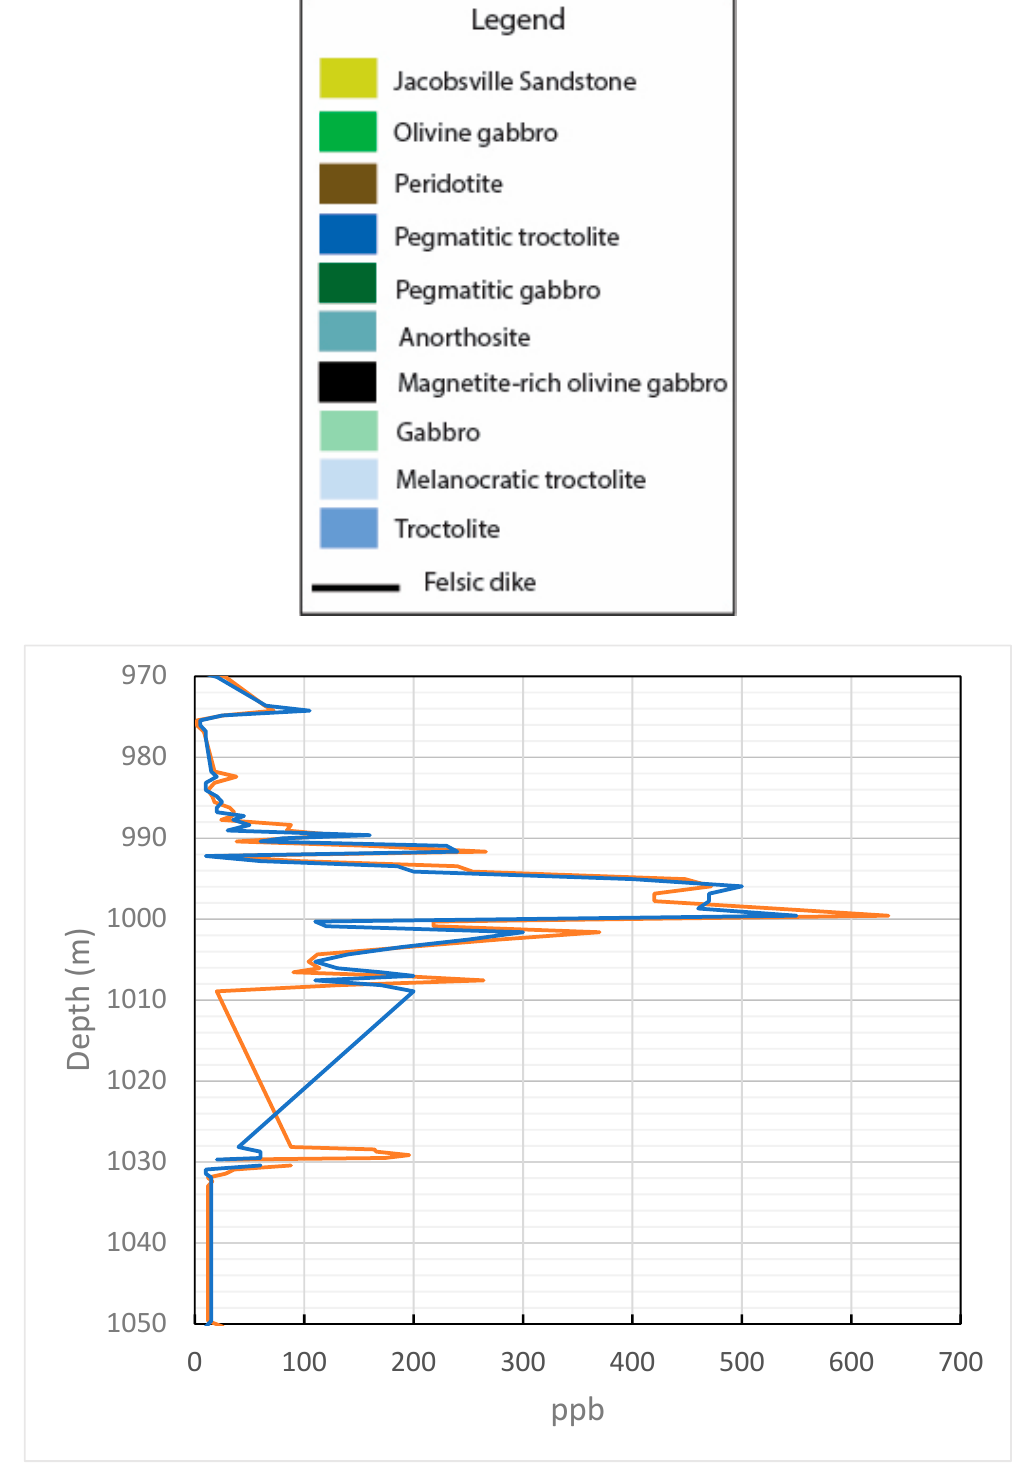
Figure 6. PGE concentrations in the mineralized zone.